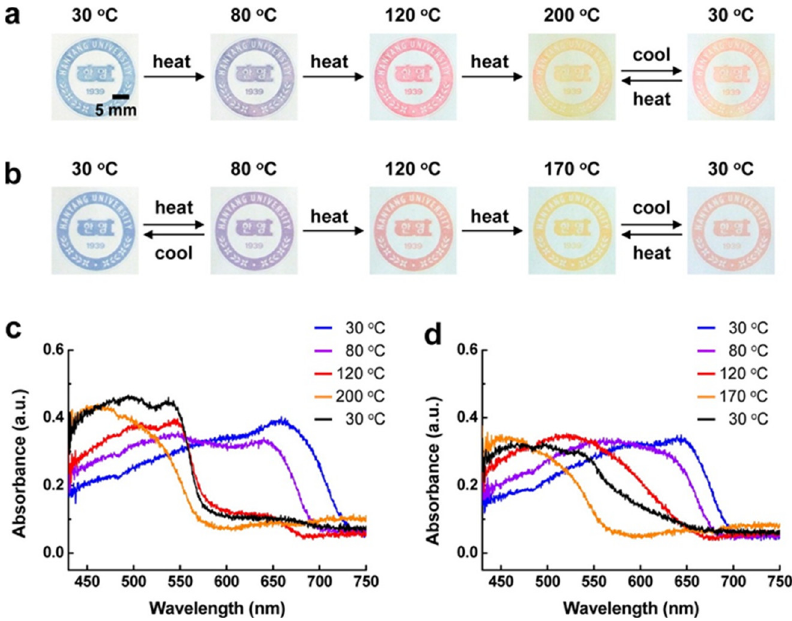
Figure 5. Photographs of printed images of ( a ) DA 2-derived PDAs and ( b ) DA 3-derived PDAs on an unmodified paper substrate upon thermal stimulation. UV–vis absorption spectra of ( c ) DA 2-derived PDAs and ( d ) DA 3-derived PDAs printed on an unmodified paper substrate as a function of the temperature. Black lines in each spectrum are the final phase involving cooling to 30 °C. Reproduced with the permission of Reference [17]. Copyright 2013 American Chemical Society.